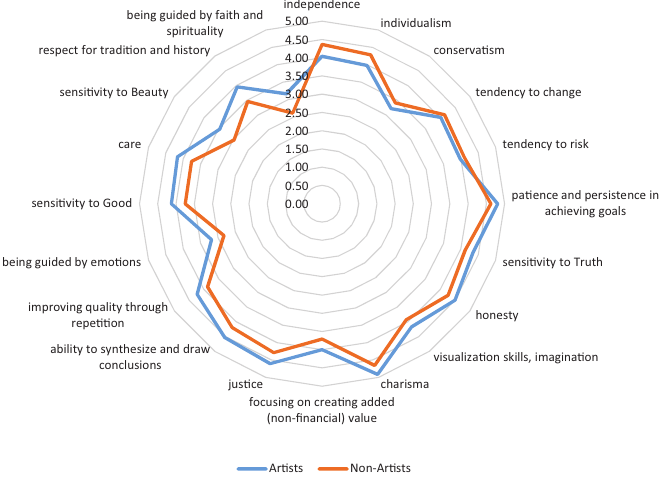
Figure 8. Perception of the most differently assessed features of a leader’s identity by artistic versus non-artistic individuals (source: created by